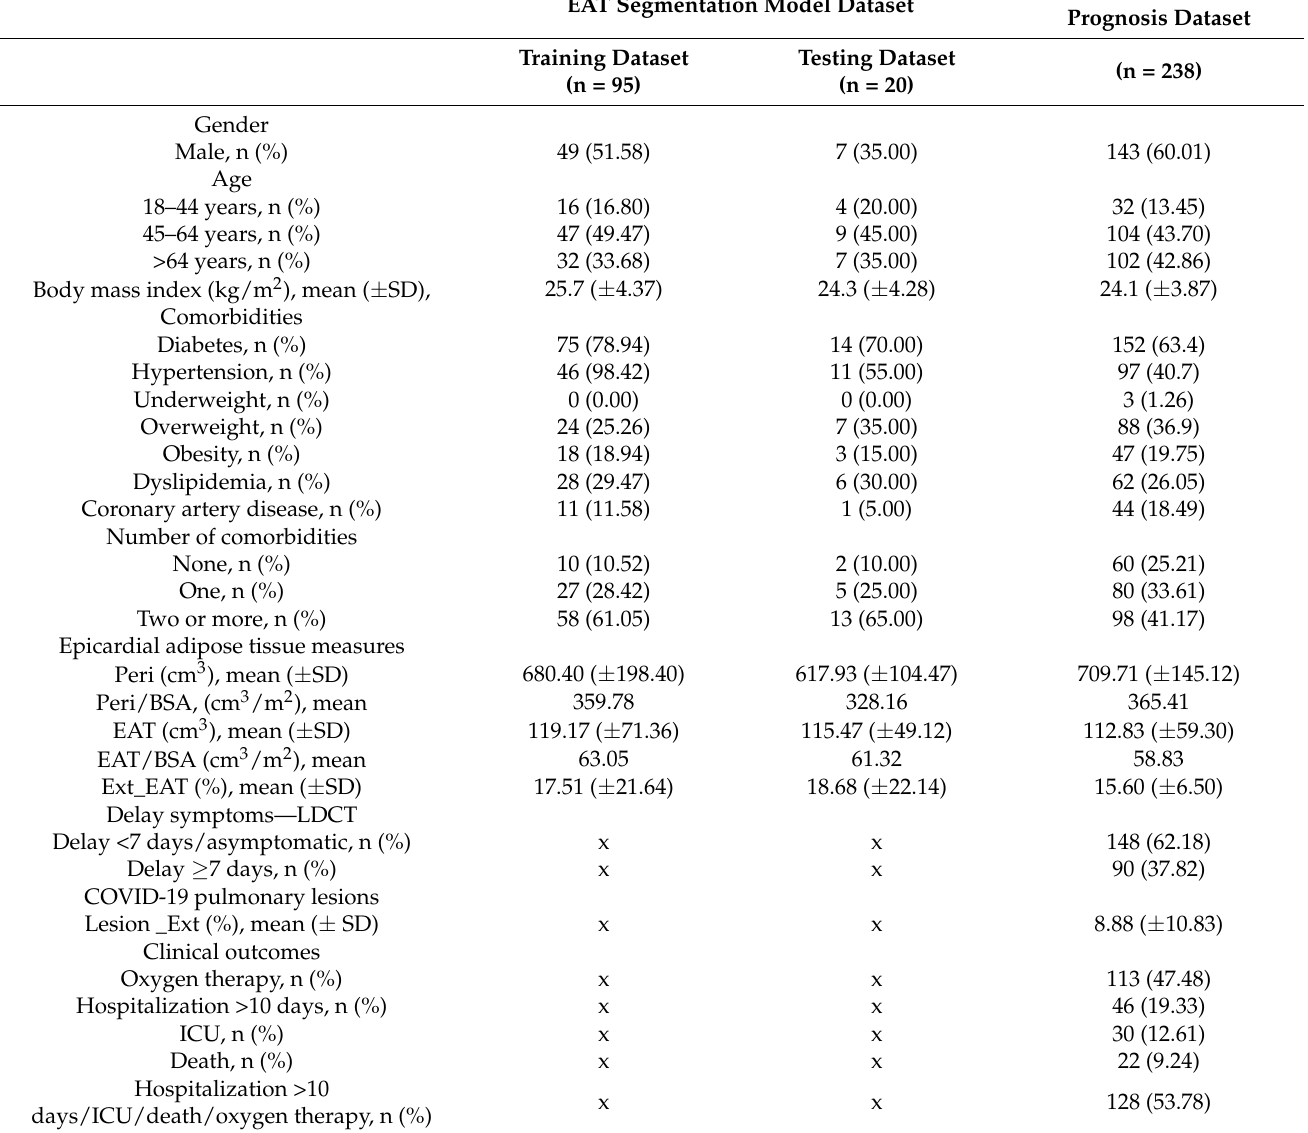
Table 1. Population characteristics. SD: standard deviation; BSA: body surface index; Peri: intra- pericardial volume; EAT: epicardial adipose tissue volume; ICU: intensive care unit; Ext_EAT: epicar- dial adipose tissue extent (%); Lesion_Ext: COVID-19 lung lesion extent